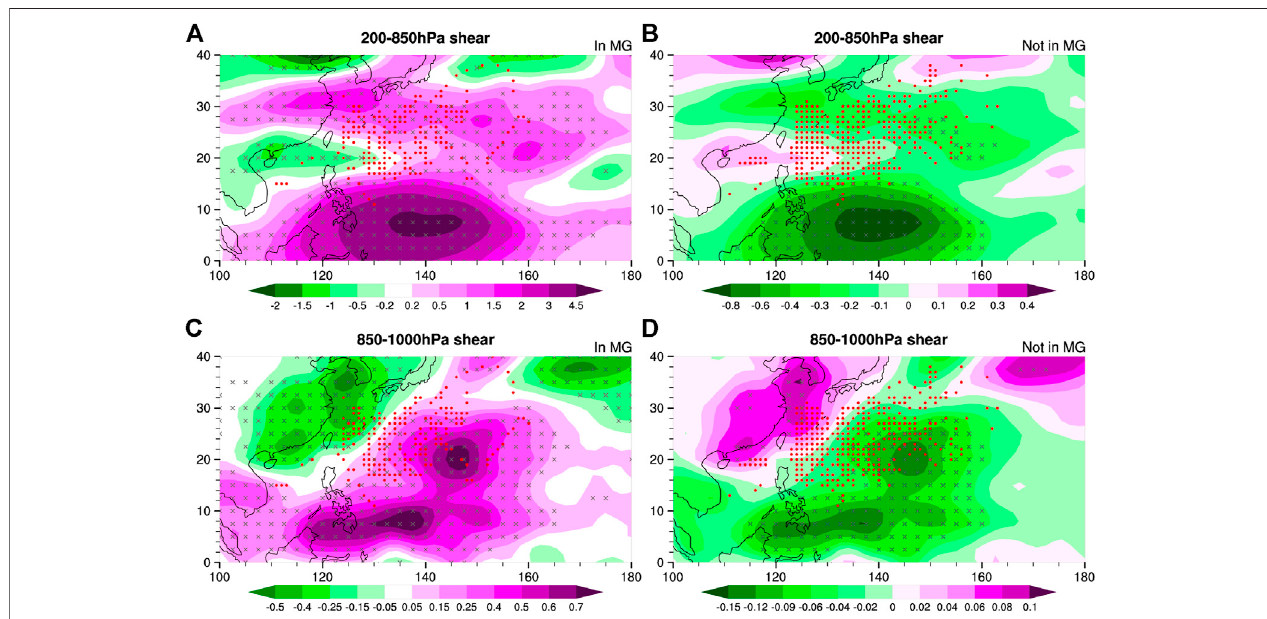
FIGURE 6 | Anomalies in deep VWS between 200 and 850 hPa (m s − 1 , shadings) with the daily climatology removed during the MG period (A) and the non-MG period (B) ,andthoseinshallowVWSbetween850and1000 hPa(ms − 1 ,shadings)duringtheMGperiod (C) andthenon-MGperiod (D) .Thereddotsarethelocations oftheRWeventsduringtheircorrespondingperiods.Theblackcrossesrepresenttheareawherethestatisticalsigni fi canceexceedsthe95%con fi dencelevelbasedon the Student ’ s t test.